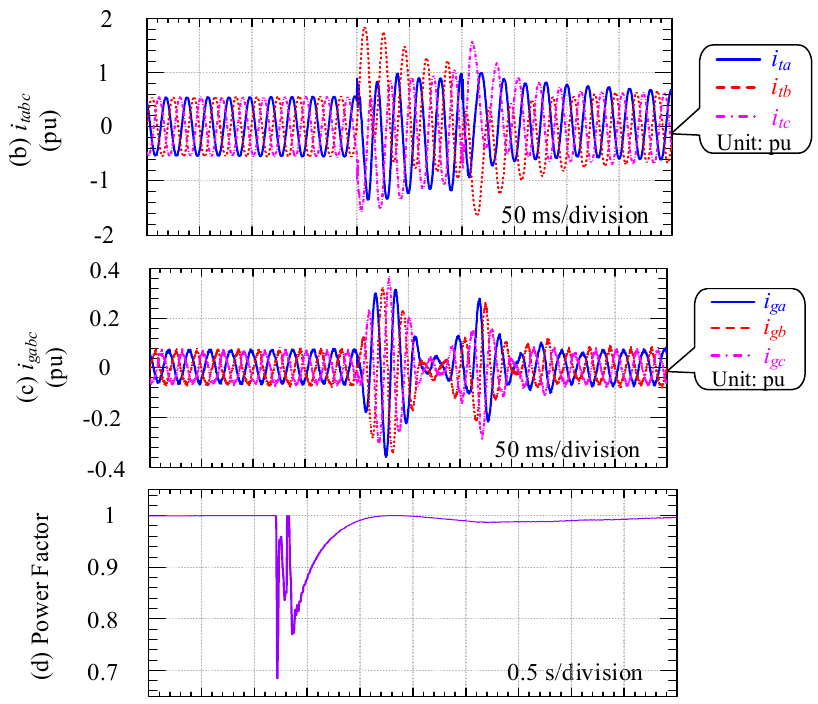
Figure 17. ( a ) DC-bus voltage V dc ; ( b ) three-phase GSC currents i gabc ; ( c ) three-phase total output currents i tabc ; and ( d ) the output power factor with wind speed fluctuation.